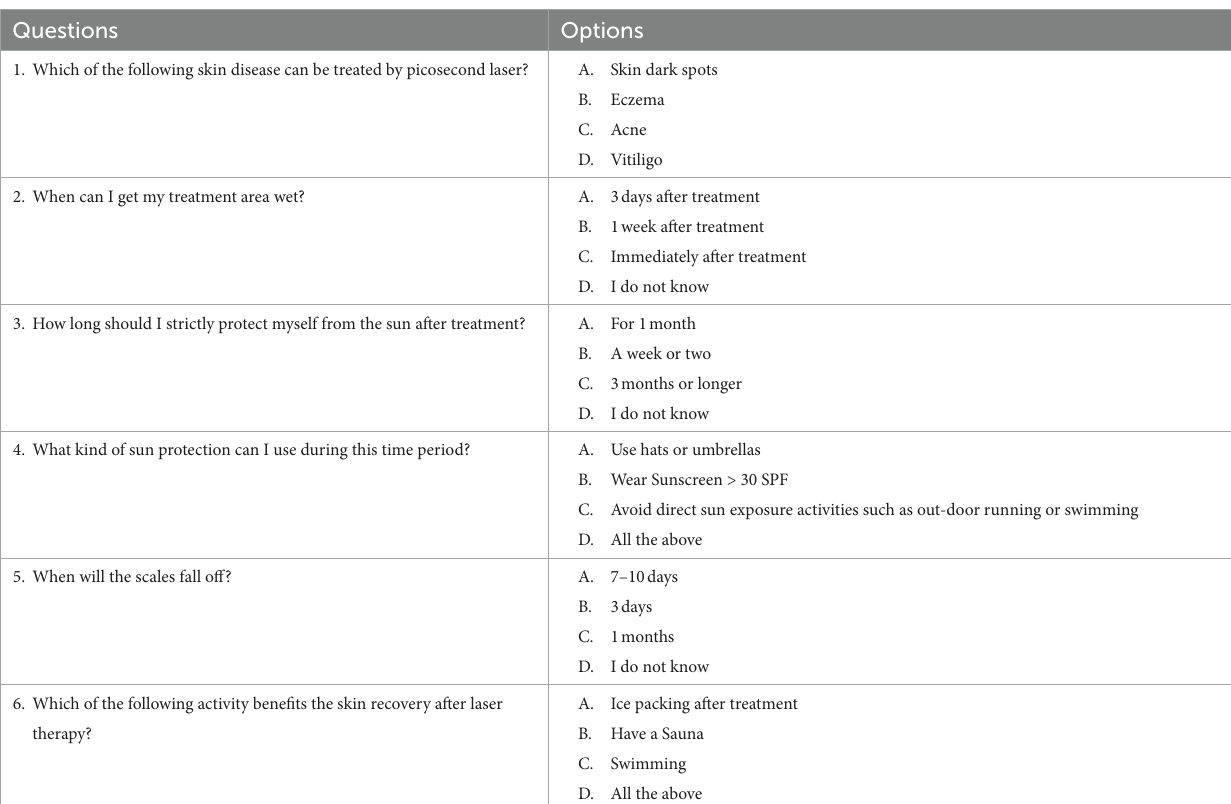
TABLE 1 Patient comprehension